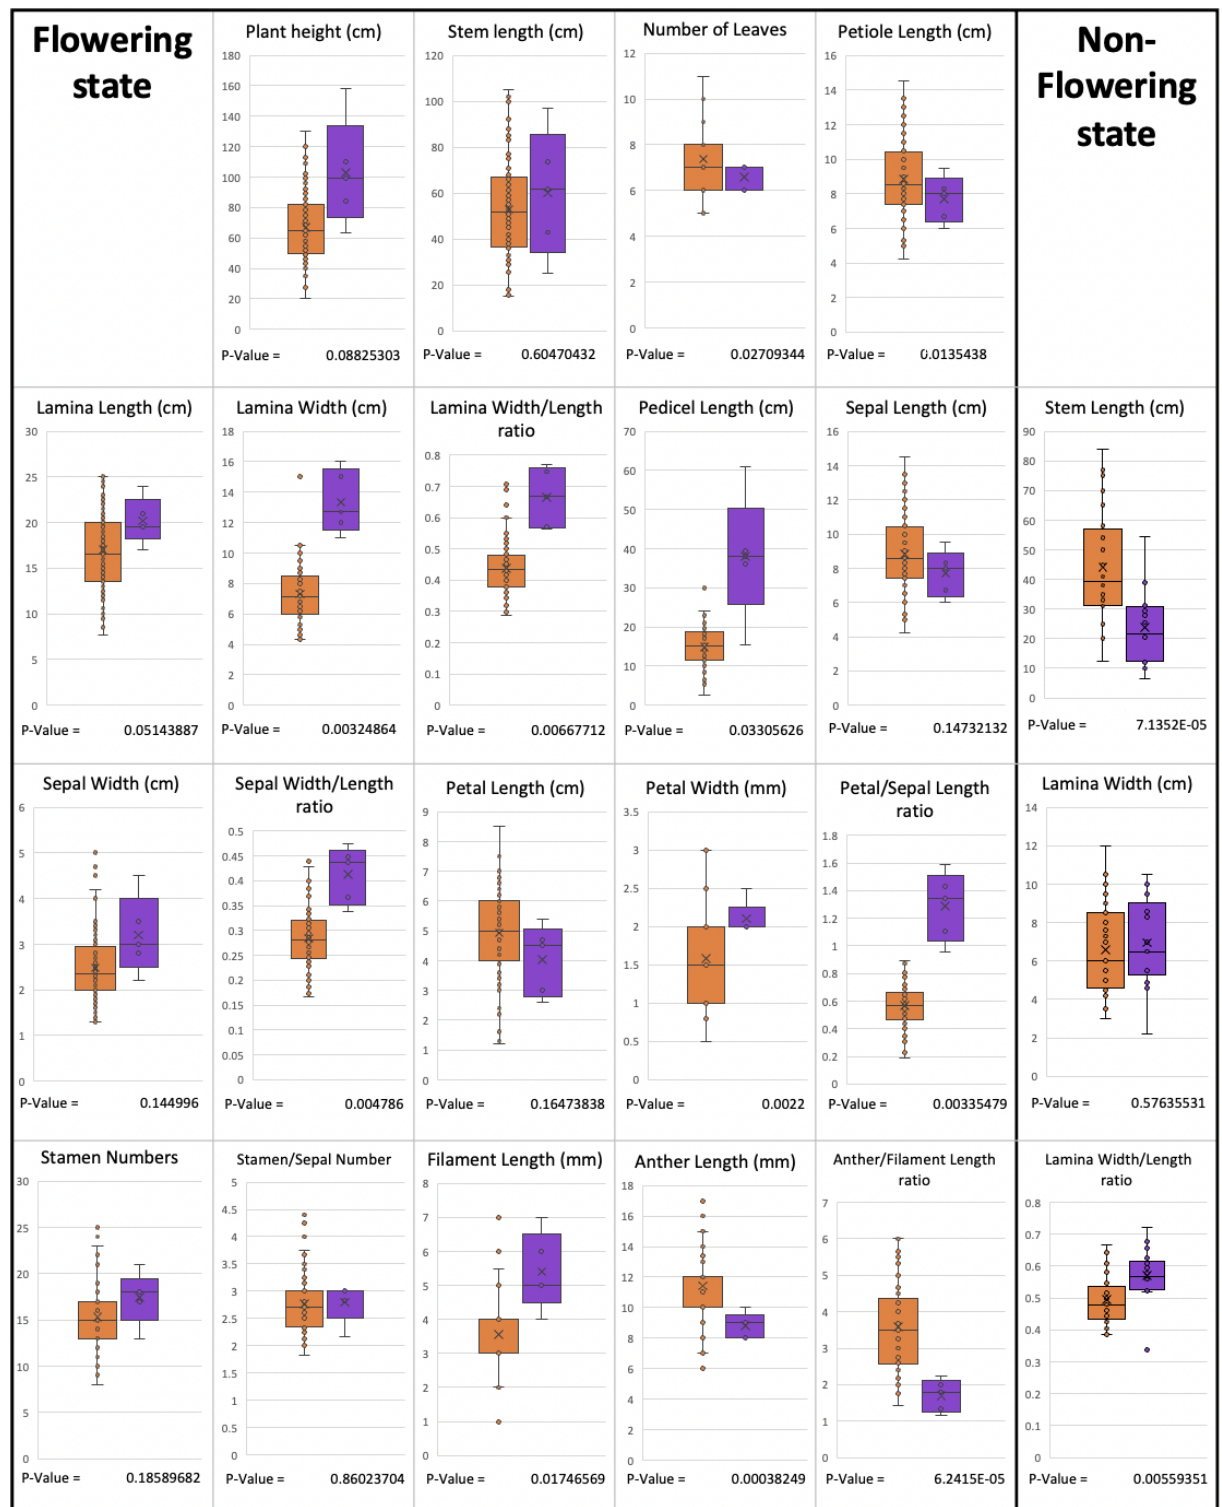
Figure 8. Comparison between some morphological characters of P. yunnanensis and P. siamensis . P- values were obtained from t-tests; brown represents P. yunnanensis, and violet represents P. siamen- p -values were obtained from t -tests; brown represents P. yunnanensis , and violet represents P. siamensis sis .